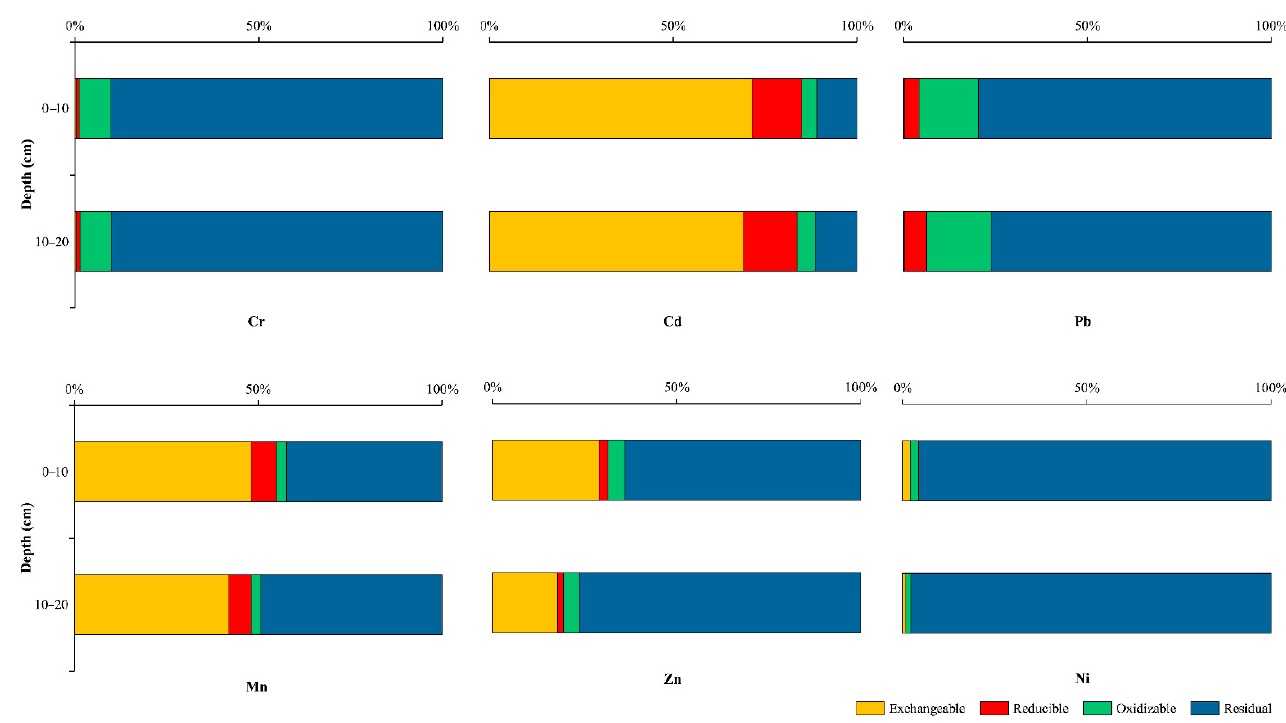
Figure 5. Percentage of each speciation for heavy metal in profile samples in HJR.